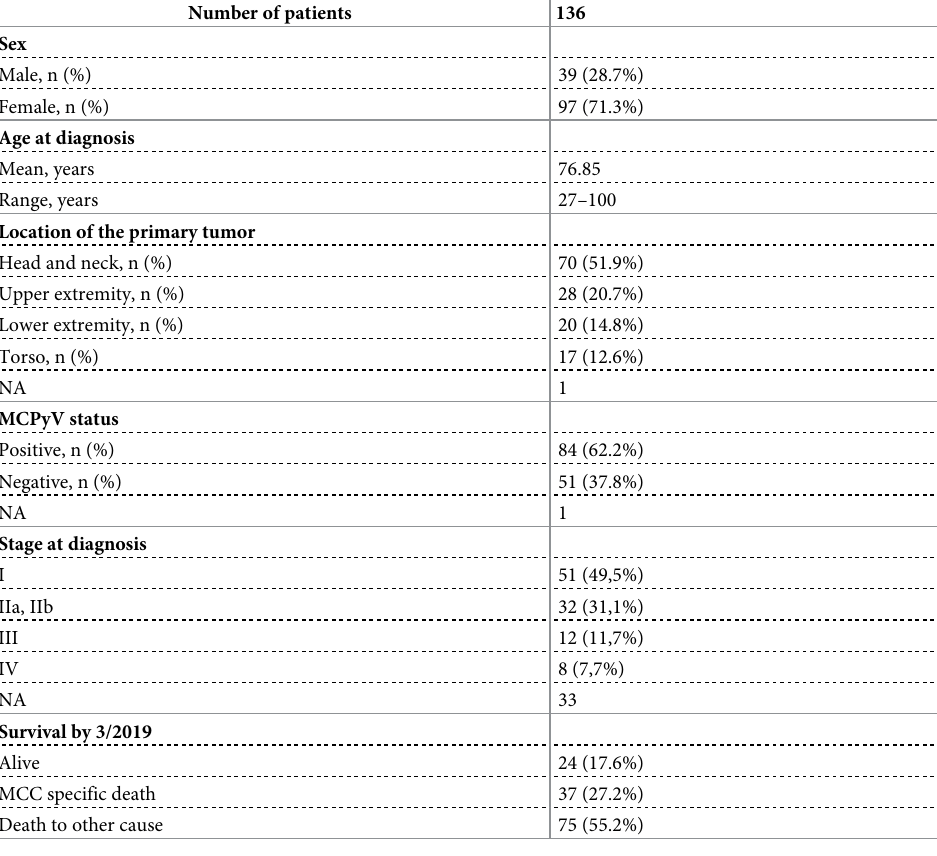
Table 1. The demographic data of 136 MCC patients with ALK and p-ALK immunostaining